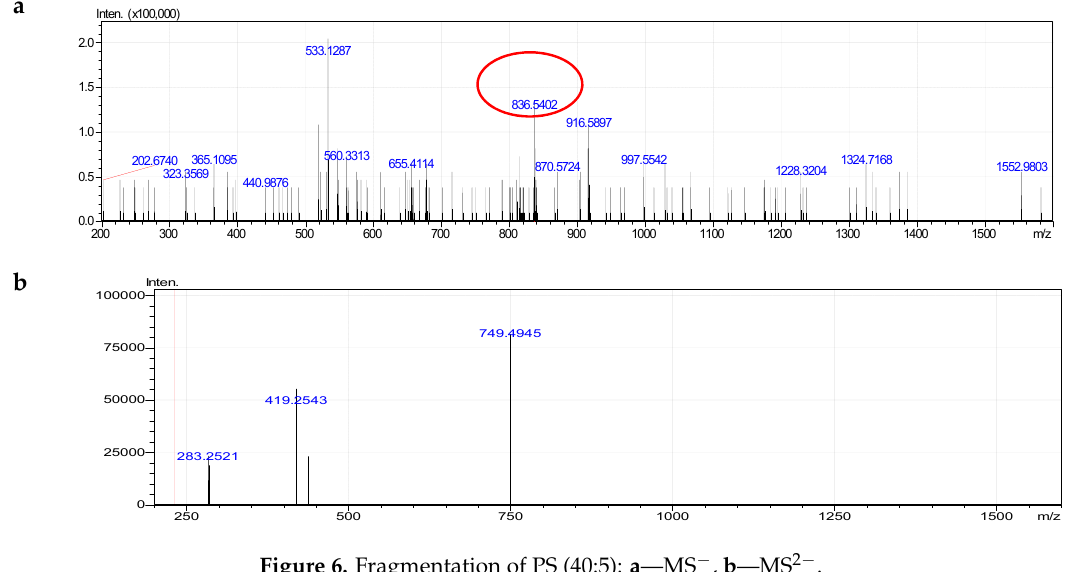
Figure 5. Fragmentation of PS (38:1): a —MS − , b —MS 2 − .